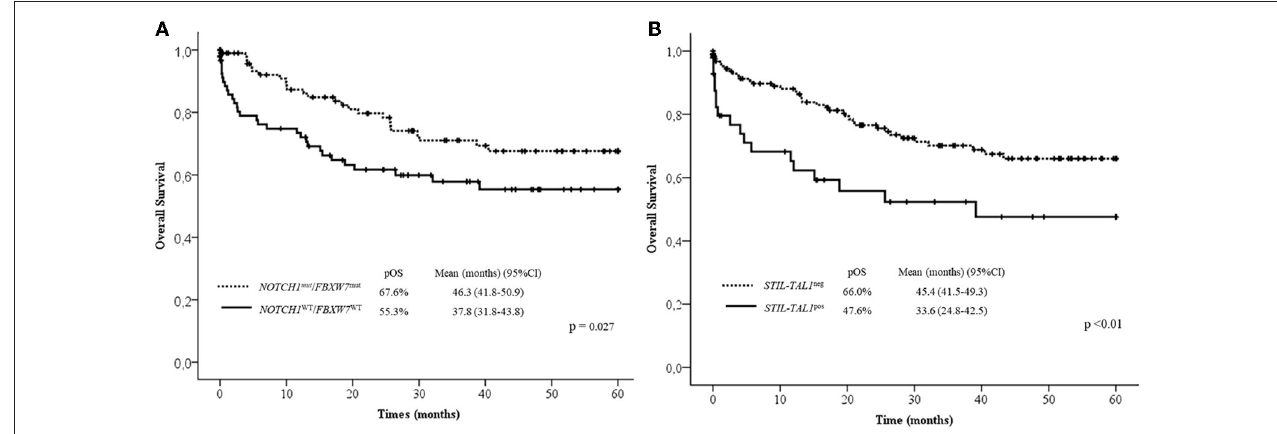
FIGURE 3 | Overall survival curves in 60 months according to NOTCH1/FBXW7 (A) and STIL-TAL1 (B) status. Mut, Mutated; WT, Wild Type; pOS, probability of overall survival; CI, confidential interval; pos, positive.